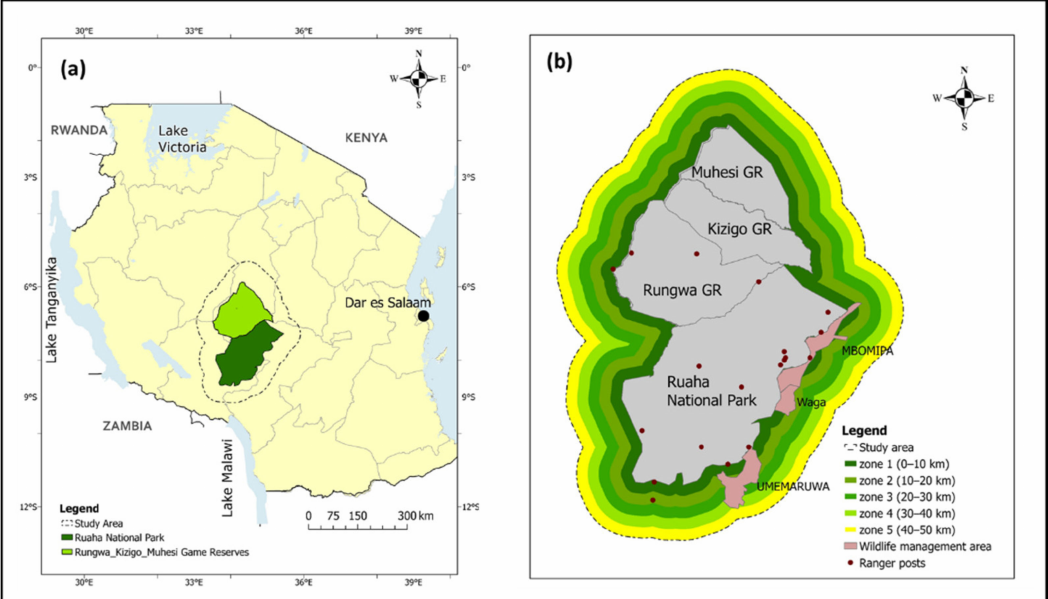
Figure 1. ( a ) Study area marked by the dashed line and ( b ) analyzed zones adjacent to the PA. The darker shades indicate zones within 0–10 km and the lighter shades represent zones within the ranges of 10–20, 20–30, 30–40, and 40–50 km from the PA boundary. GR: game